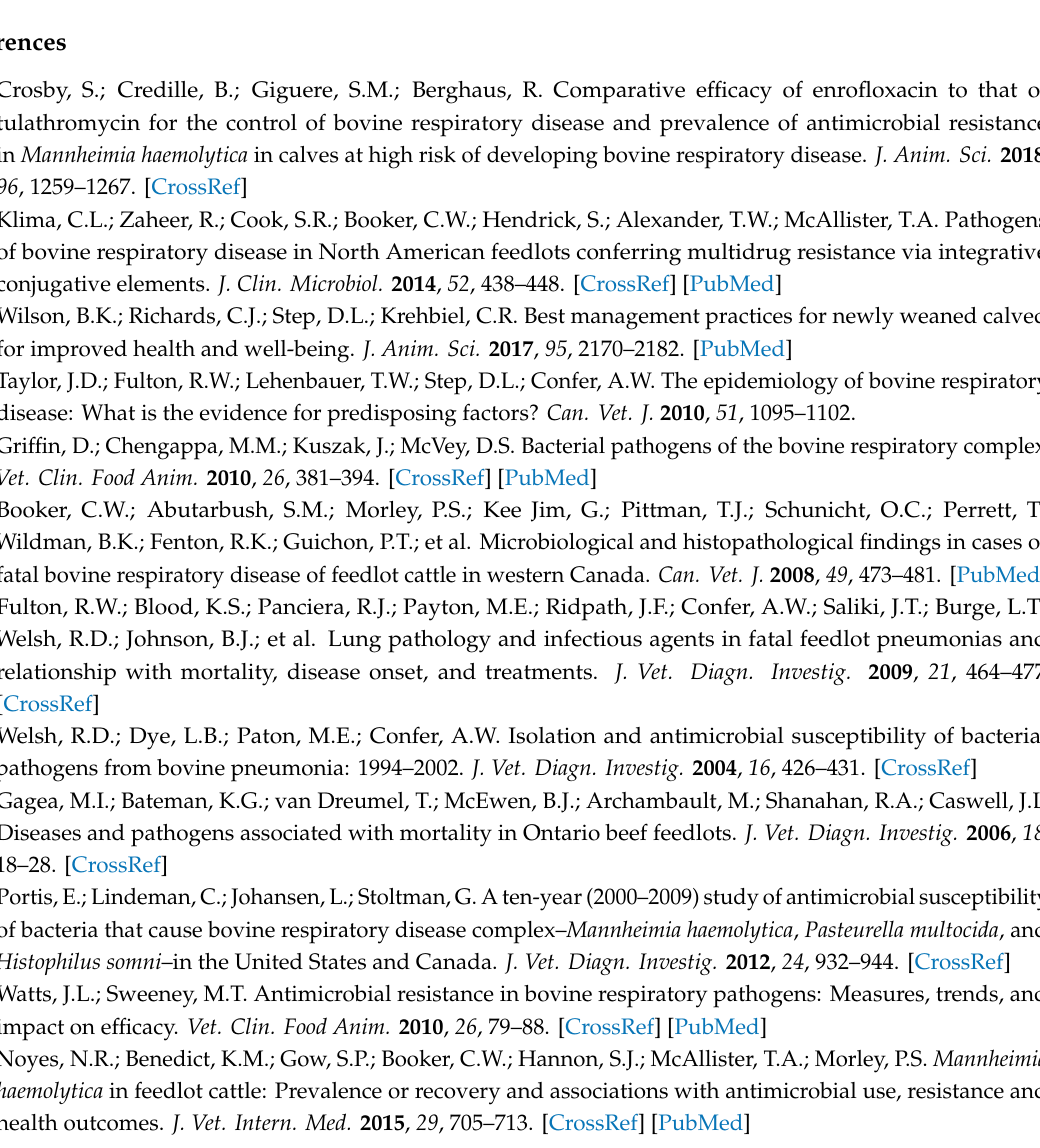
Table S3: Distribution of minimum inhibitory concentrations (MICS) of Pasteurella multocida ( n = 45) isolated from lung tissue of bovine respiratory disease mortalities. Table S4: Distribution of minimum inhibitory concentrations (MICS) of Histophilus somni ( n = 23) isolated from lung tissue of bovine respiratory disease